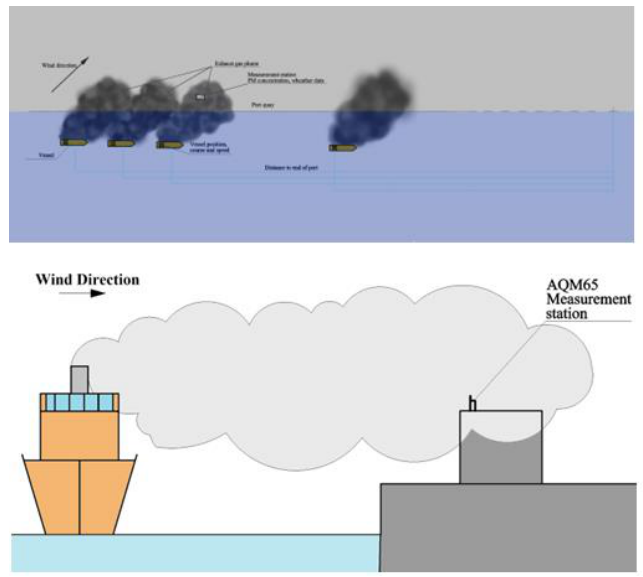
Figure 1. Schematic representation of exhaust gas plume measurement. The position of every ship (coordinates and position relative to the end of port), speed above ground as well as weather parameters are registered at time t x with time intervals of 1.5 min. Ship technical data is added from the ship register database based on the IMO number. Exhaust gas plume measurements were made with AQM 65 measurement station [40]. Pollutants’ measurement (PM1, PM2.5, PM10) was conducted 24/7 with a measuring time interval of 1 min for 46 days. Time intervals of the position of every ship (coordinates and position relative to the end of port), speed above ground, as well as weather parameters and pollutant measurements were synchronized according to AIS data, using linear interpolation, for final data array.